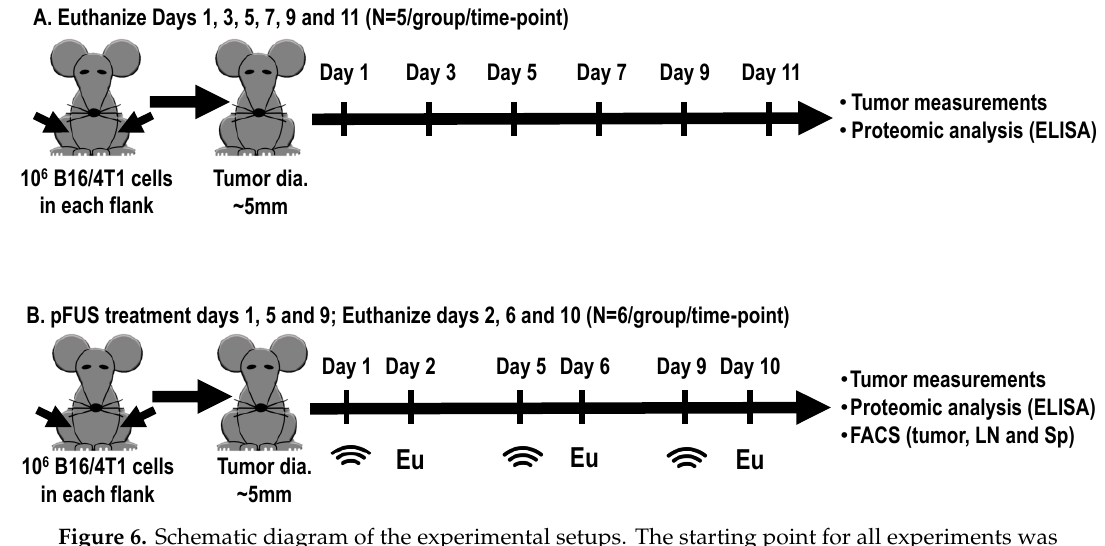
Figure 6. Schematic diagram of the experimental setups. The starting point for all experiments was defined once tumor sizes reached ~5 mm in diameter. ( A ) Natural history growth of xenograft B16 or 4T1 tumors, harvested every other day without treatment for molecular analysis. ( B ) Tumors were treated with 6 MPa pFUS on days 1, 5, or 9, and tumors, spleens (Sp), or regional lymph nodes (LNs) were harvested 24 h for molecular, flow cytometry (FACS), and histology; pFUS: Pulse focus ultrasound; Eu: Euthanize.